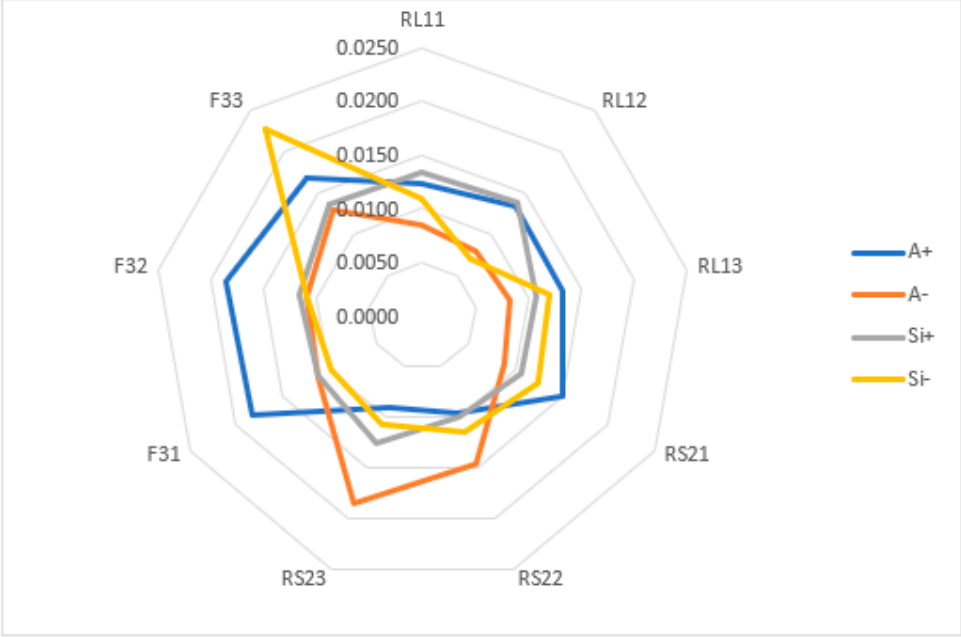
Figure 8. Separation from positive and negative ideal solutions for scenario 1 KPIs.